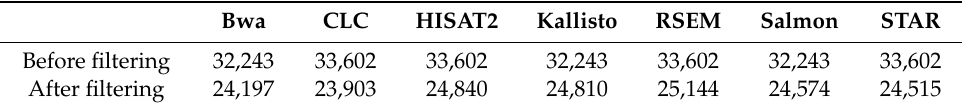
Table 1. Number of expressed genes identified in all samples before and after filtering out lowly expressed genes. Bwa CLC HISAT2 Kallisto RSEM Salmon STAR Before filtering 32,243 33,602 33,602 32,243 33,602 32,243 33,602 After filtering 24,197 23,903 24,840 24,810 25,144 24,574